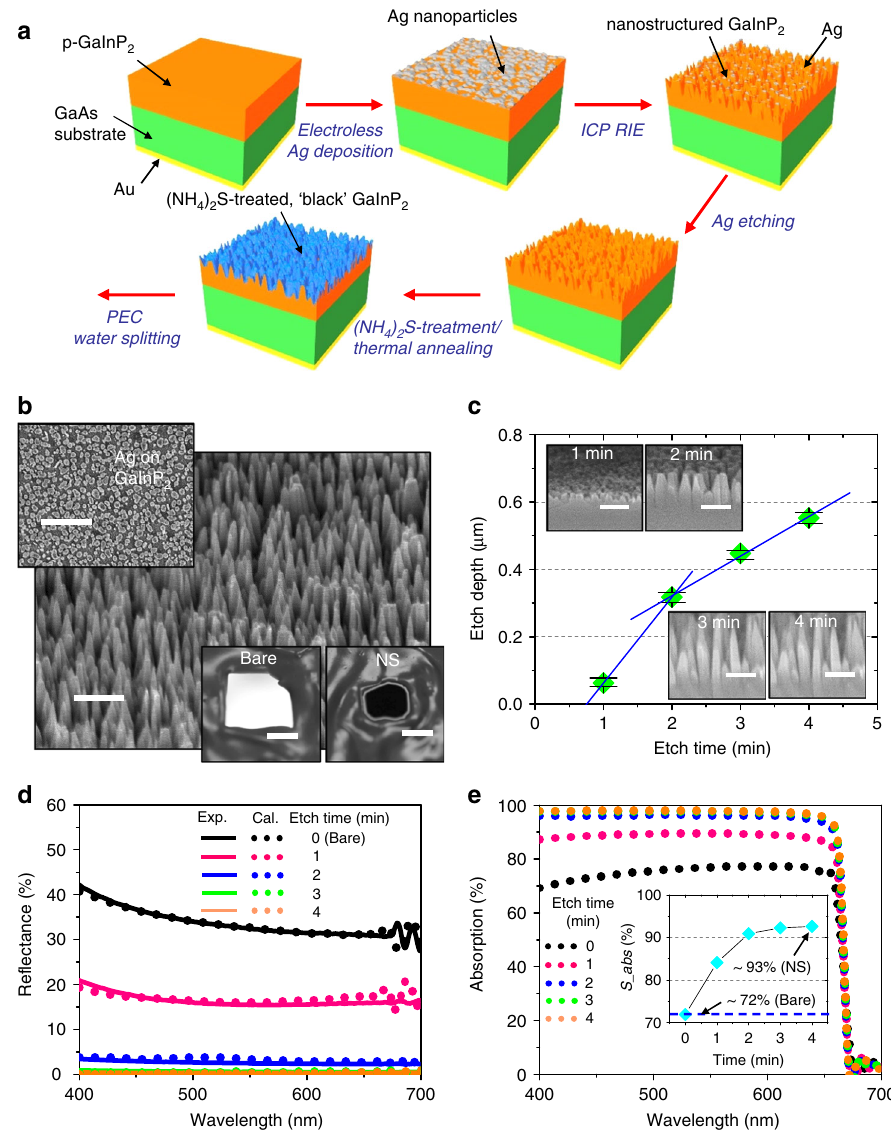
Fig. 1 Schematic illustration, morphological and optical properties of surface-tailored GaInP 2 photocathodes. a Schematic illustration of fabrication procedures for surface-tailored black GaInP 2 photocathodes. b Tilt-view scanning electron microscope (SEM) image of nanostructured p-type GaInP 2 photocathodes after the dry etching and before the (NH 4 ) 2 S-treatment (scale bar: 500 nm). The top inset shows a SEM image of electrolessly deposited silver nanoparticles on GaInP 2 as a mask for dry etching (scale bar: 1 μ m). The bottom inset shows photographic images of fully functional bare (labeled as “ Bare ” ) and nanostructured (labeled as “ NS ” ) GaInP 2 photocathodes mounted on a slide glass with epoxy encapsulation (scale bar: 5 mm), where the black surface of nanostructured GaInP 2 is evidently shown in contrast to the shiny surface of bare GaInP 2 . c Etching depth of the nanostructured GaInP 2 (yet without (NH 4 ) 2 S-treatment) measured from cross-sectional SEM images (inset) at etching times of 1, 2, 3, and 4 min (scale bar: 300 nm). Error bars represent the range of values obtained from three separate measurements ( n = 3). d Corresponding total (i.e., specular and diffuse) re fl ectance spectra of nanostructured GaInP 2 measured on spectrophotometer equipped with an integrating sphere at an incidence angle of 8°. Calculated (dotted line) re fl ectance spectra obtained from FDTD-based numerical optical modeling matched well with the experimental (solid line) spectra. e Calculated absorption spectra of nanostructured GaInP 2 in water using the numerical model established in d . The inset shows corresponding integrated solar fl ux